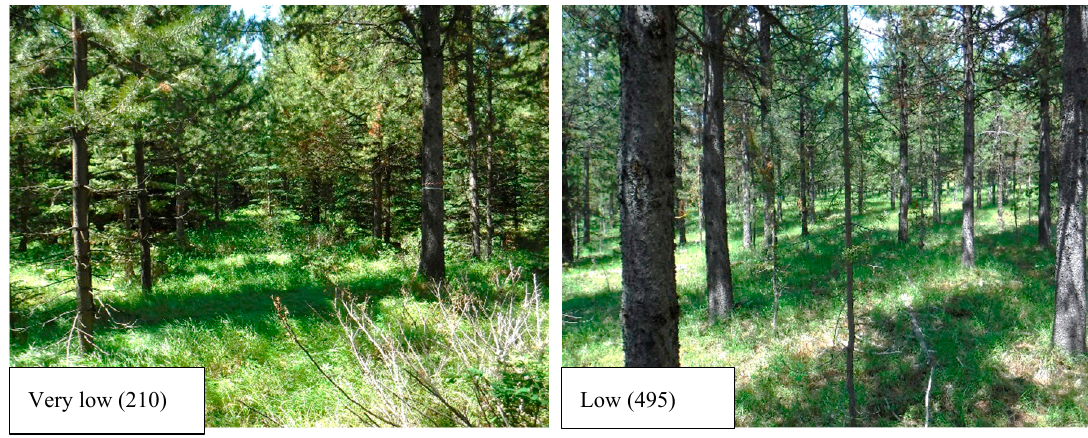
Table 1. Experimental design and characteristics of lodgepole pine stands for the pre-commercial thinning (PCT) and PCT with fertilization (PCT+FERT) studies, 25 years after initiation of